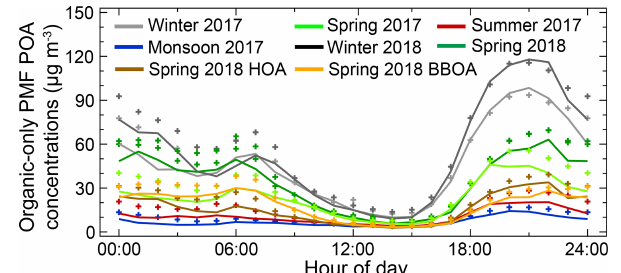
Figure 3. Seasonally representative diurnal mean ( + ) and median concentrations (lines) of POA from organic-only PMF analysis. This figure shows that POA exhibits extreme diurnal variations and displays two peaks, corresponding to the early morning and late evening traffic